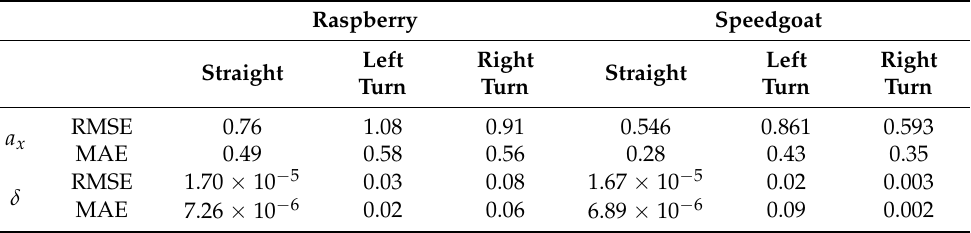
Table 3. RMSE and MAE values for the controlled variables a x and δ in both PIL architectures. Raspberry Speedgoat Left Right Left Straight Straight Turn Turn